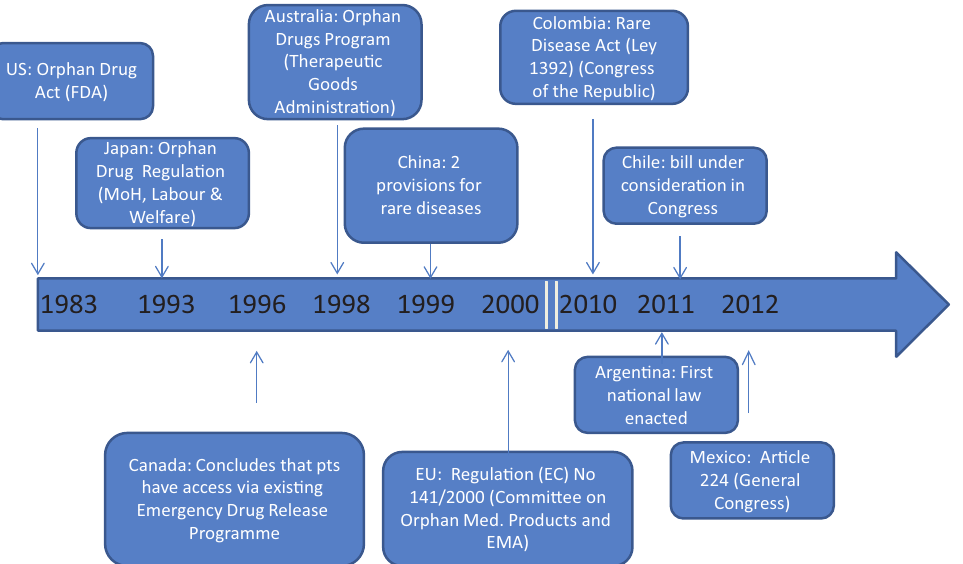
Figure 1. Timeline of legislation surrounding rare diseases in different